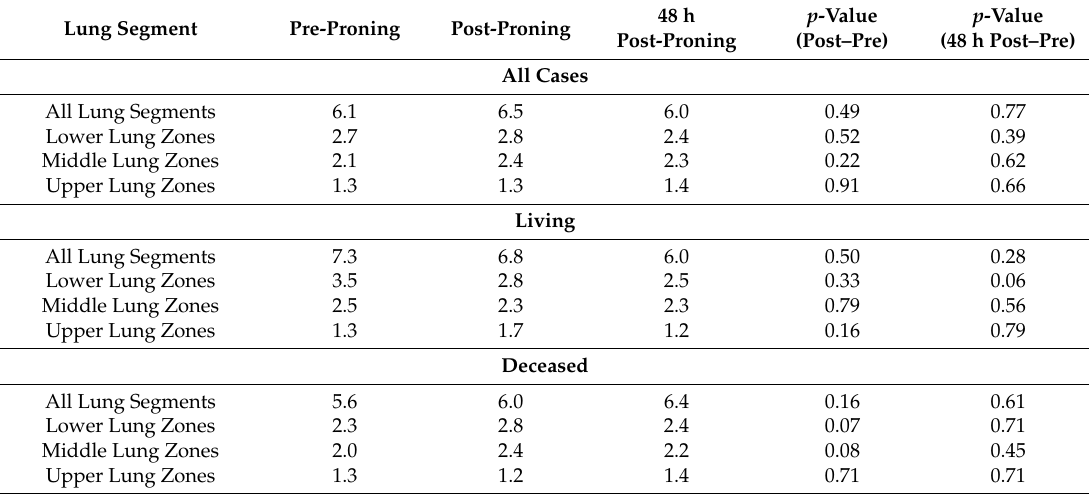
Table A1. Mean lung severity scores by lung segment.